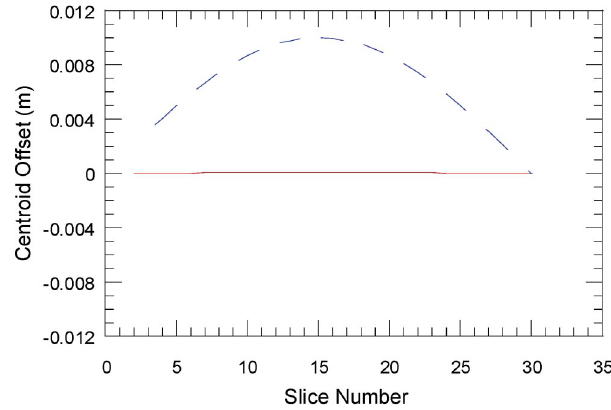
FIG. 3. (Color) Initial electron-beam centroid offsets, versus slice number. The red line is the horizontal offset and the blue line is the vertical